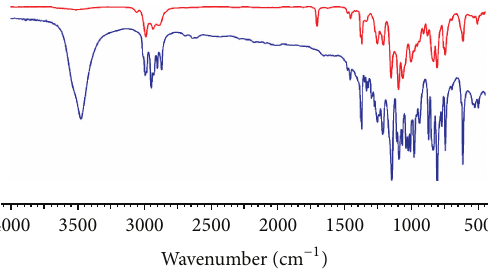
Figure 1: The FTIR spectrums of compounds 1 and 2